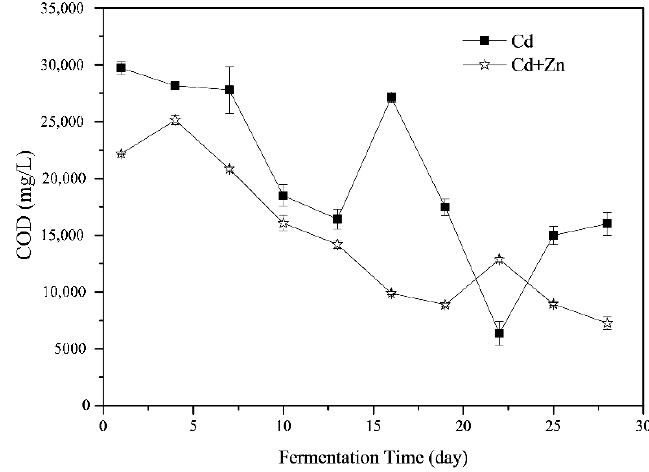
Figure 4. Impact of Cd and Cd+Zn addition on chemical oxygen demand (COD) during the Figure fermentation.